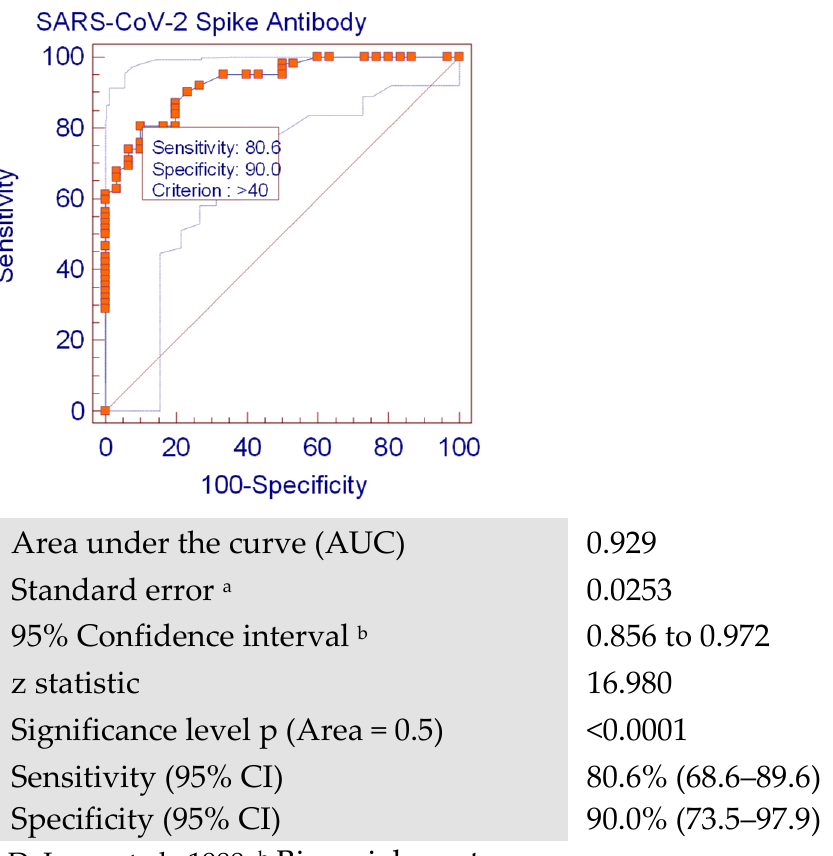
Figure 1. ( a , b ): Boxplot illustrating the differences in the titers of SARS-CoV-2 anti-S and %IH of nAbs of 92 Sinopharm vaccine recipients.